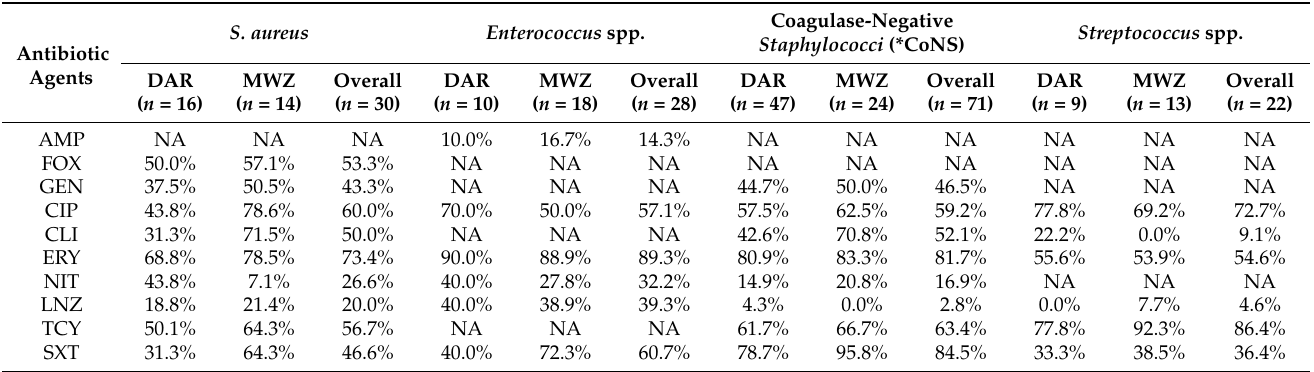
Table 4. Percentages resistance of Gram positive uropathogens causing community-acquired urinary tract infections in Tanzania.